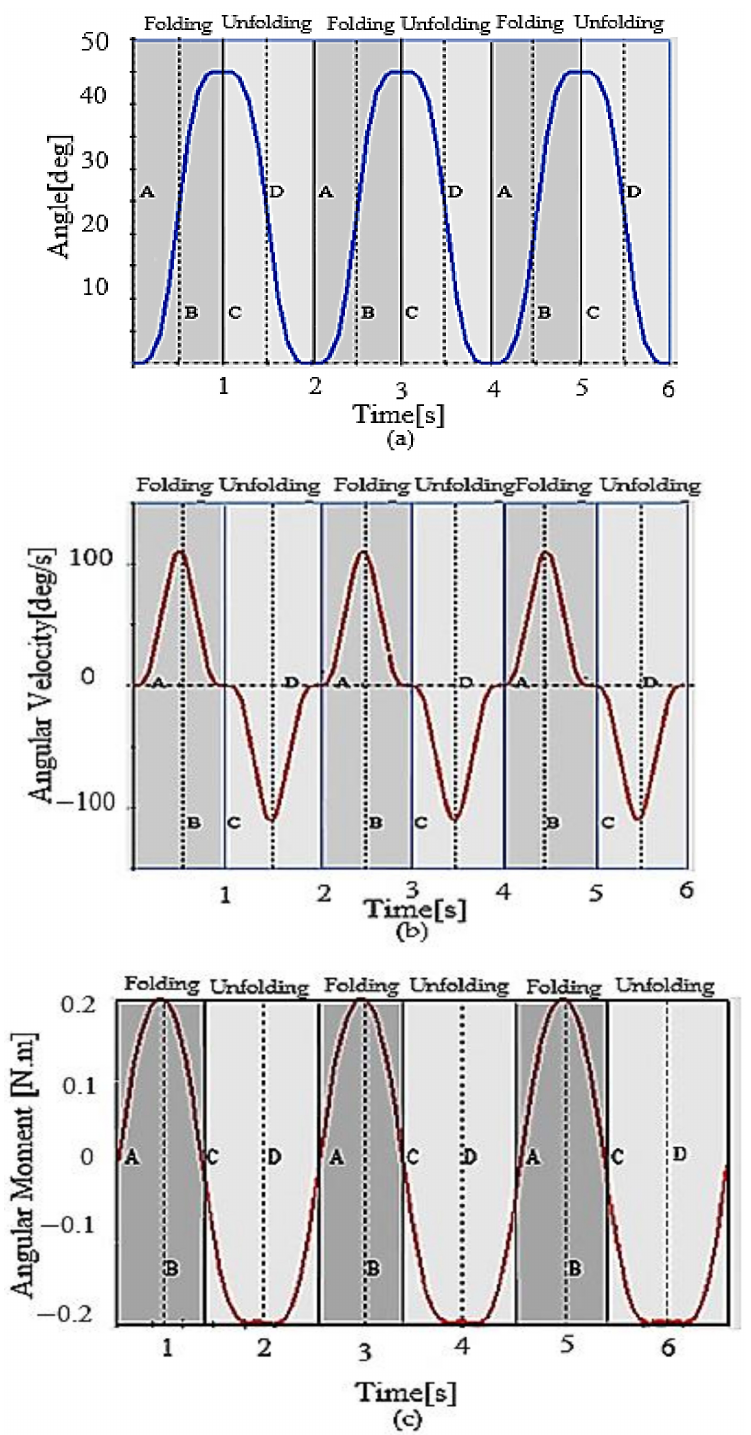
Figure 6. Analysis of the folding mechanism; ( a ) Angular position of the motor arm ( b ) The required angular velocity for servo motor actuation ( c ) The required torque for servo motor